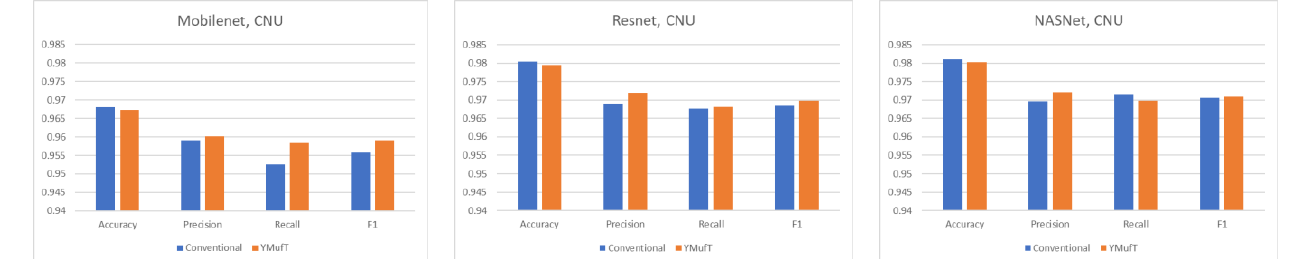
Figure 11. Performance of models trained on the CNU Weeds dataset using the conventional training strategy (upper row) and the YMufT strategy (lower rows).